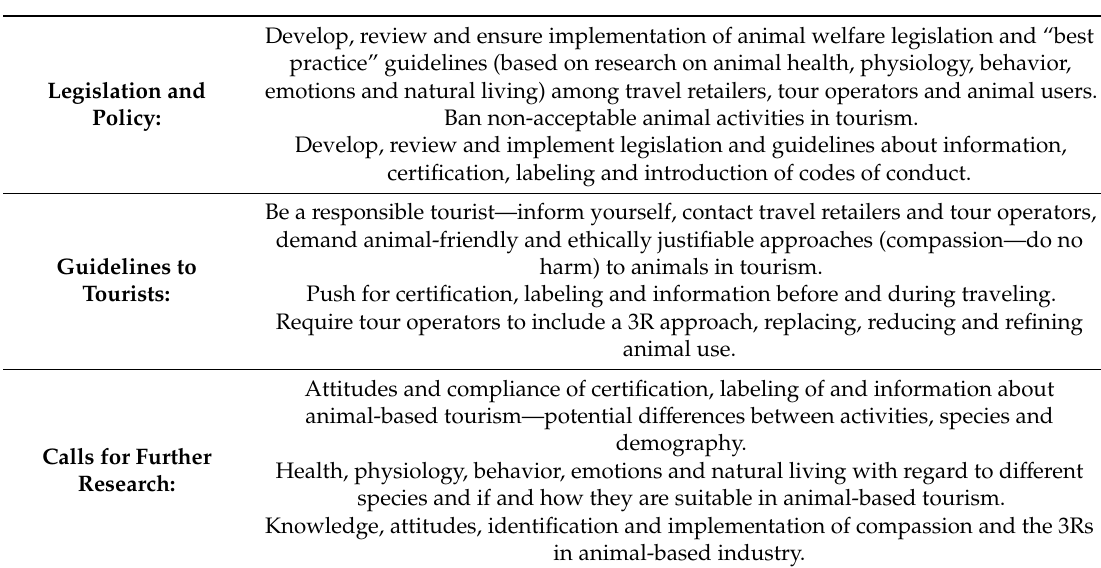
Table 4. Summary of workshop conclusions on legislation and policy, guidelines to tourists and calls for further research on compassionate animal-based